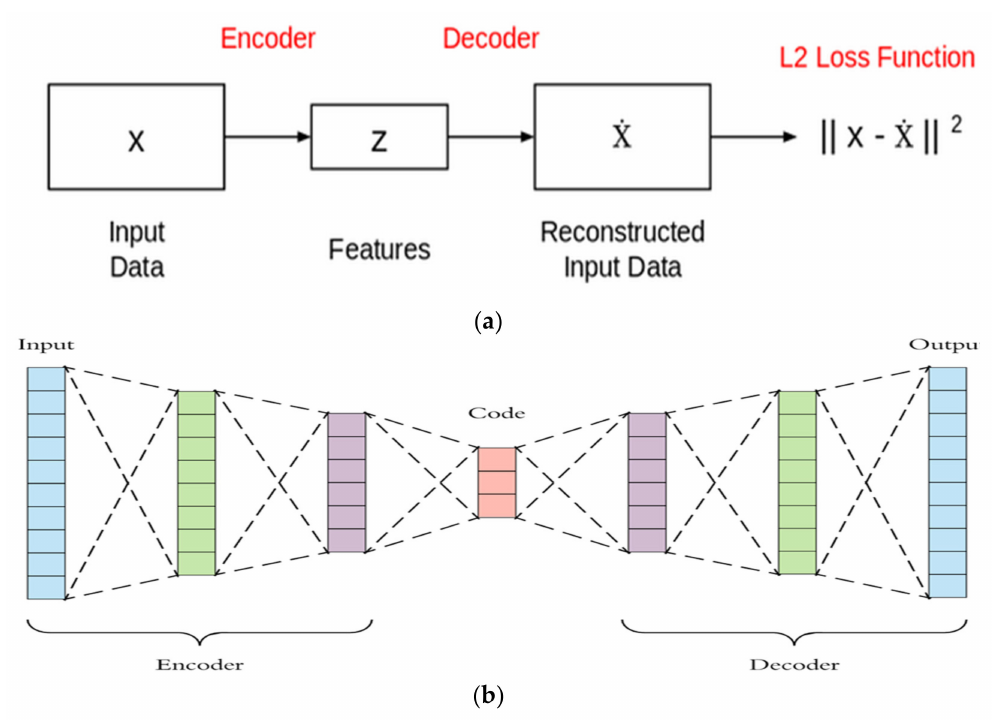
Figure 9. ( a ) Simplified autoencoder model. ( b ) Visual representation of autoencoder architecture.